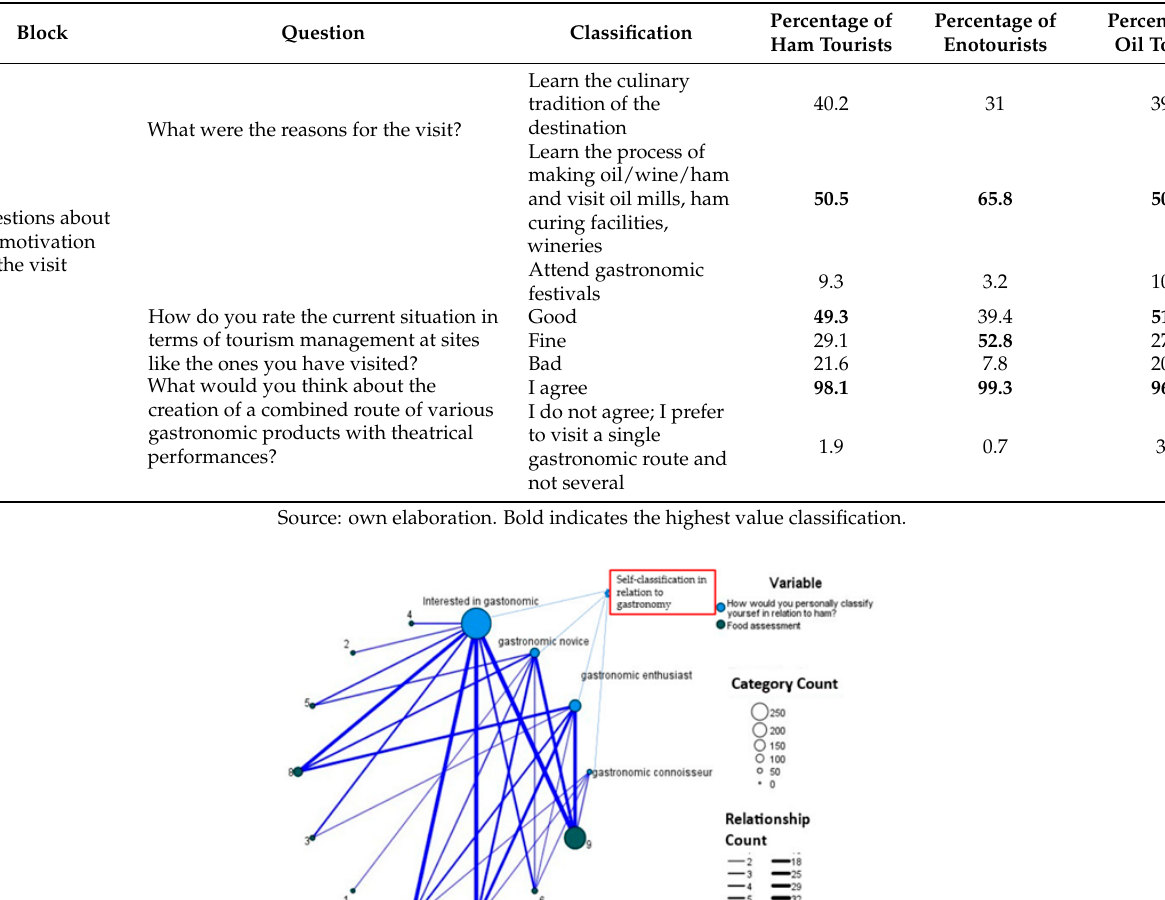
Table 5. Univariate results of the survey of gastronomic tourists: motivations.